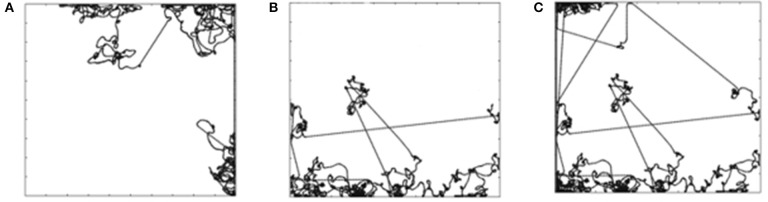
(A) Trajectory for aG5. (B) Trajectory for aG22 (run for 25,000 steps). (C) Simultation for a aG22 run for 100,000 steps.